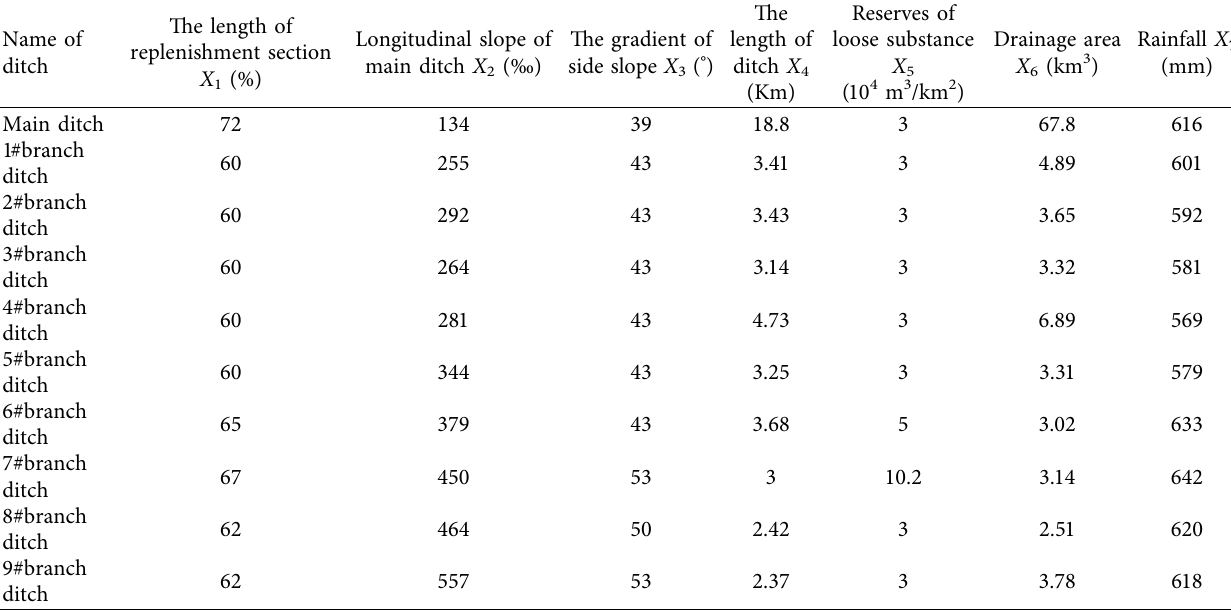
Table 2: The synthetic parameters of debris flow.